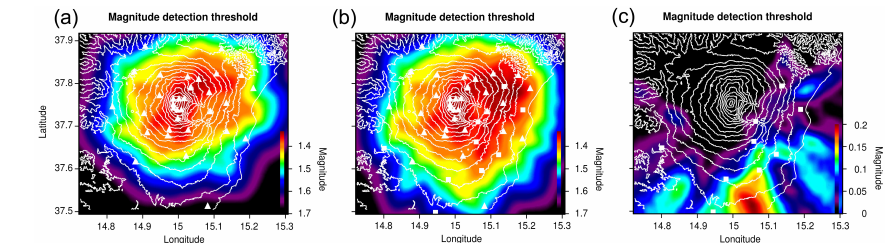
Fig. 4. Magnitude detection threshold maps determined for (a) ESN, (b) ESN + CS and (c) (ESN +